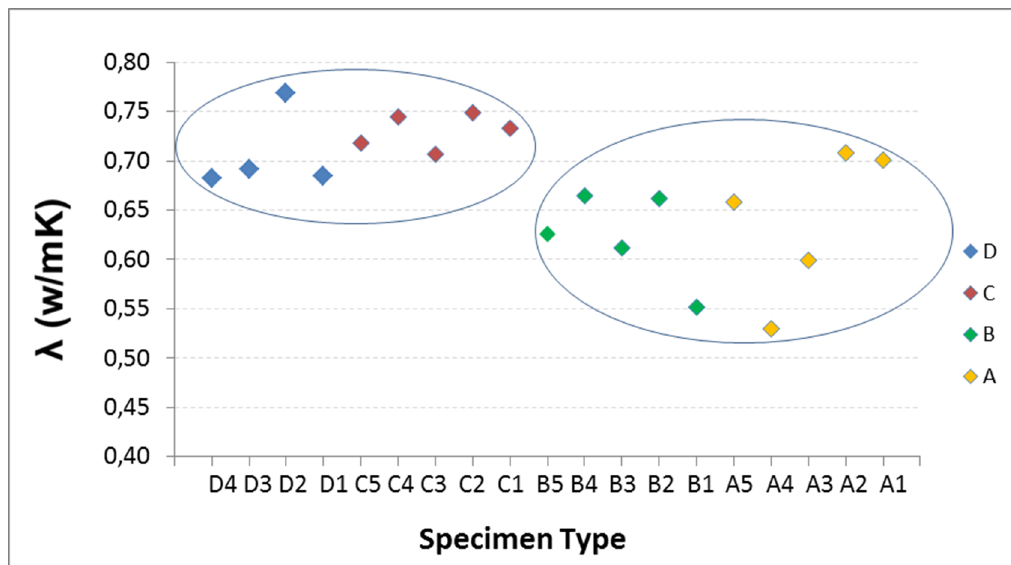
Figure 9. Influence of recycled aggregate percentage on thermal conductivity at 25 °C.